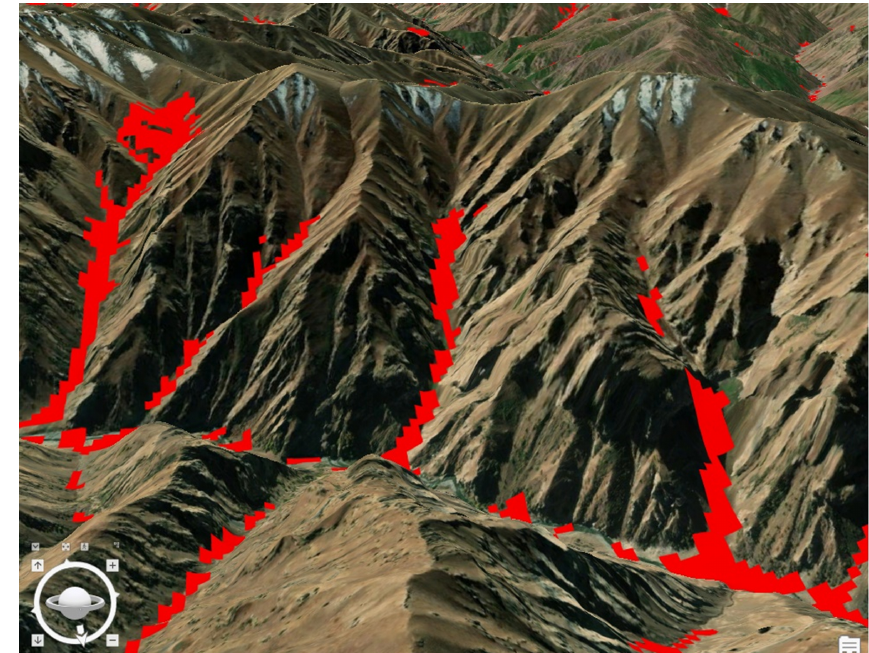
Figure 5. A 3-dimension view of the 32-year avalanche depositional zone maps in Khinj village in Afghanistan (ArcGIS